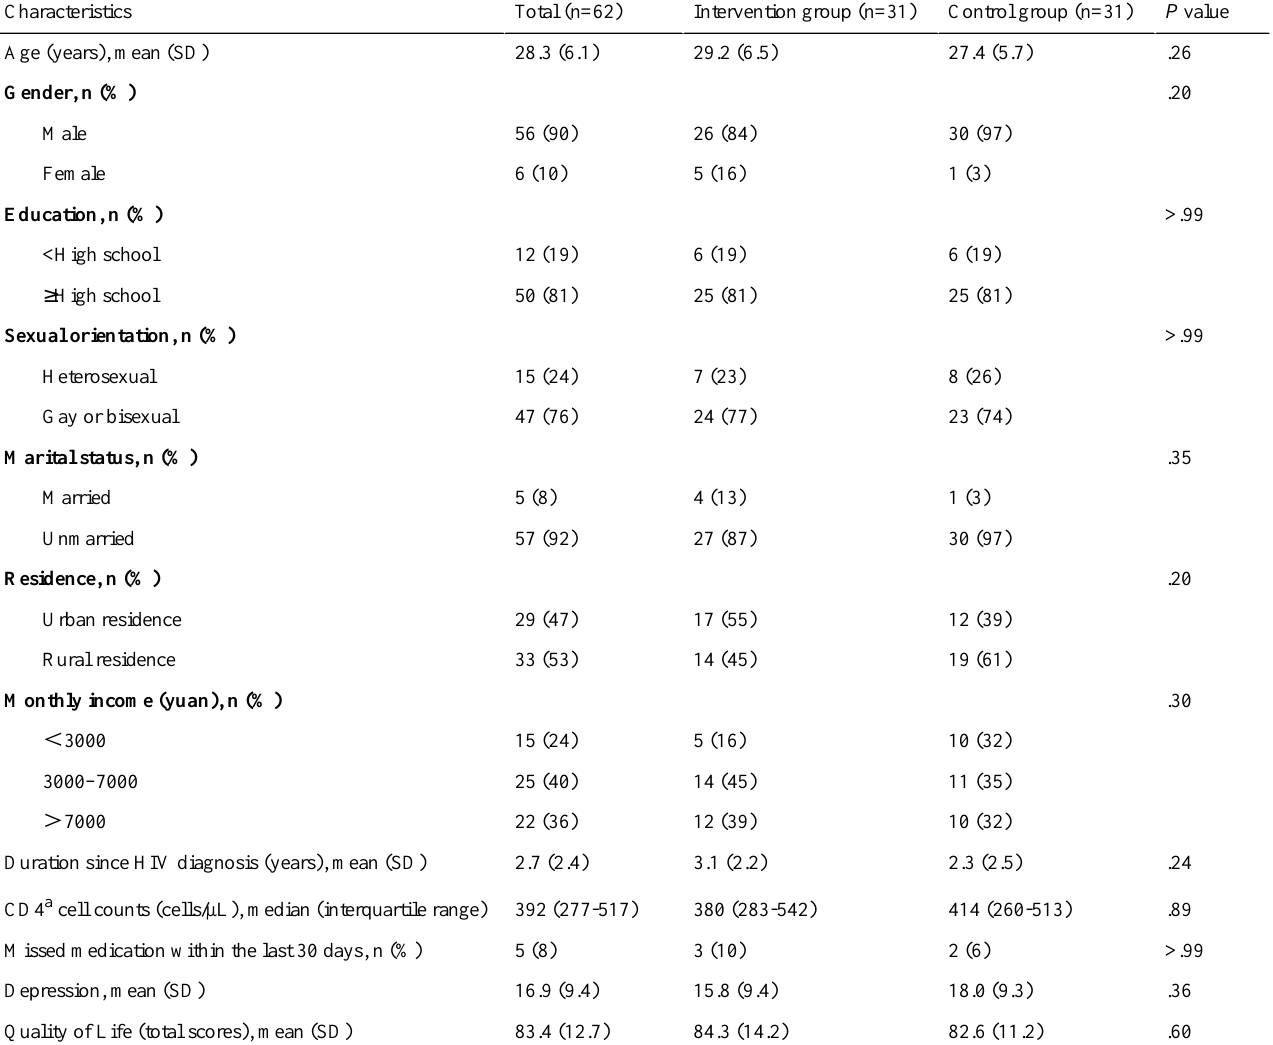
Table 1. Participants’characteristics and primary outcome measures at baseline.